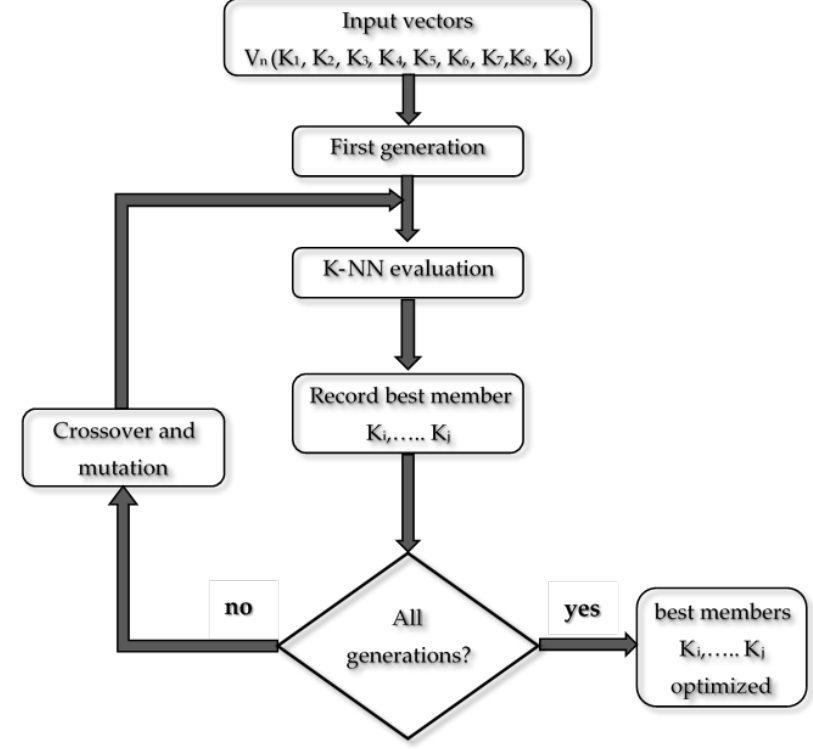
Figure 2. Preprocessing stage using K-nearest neighbor (K-NN) algorithm for the evaluation of genetic algorithms (GA) members.